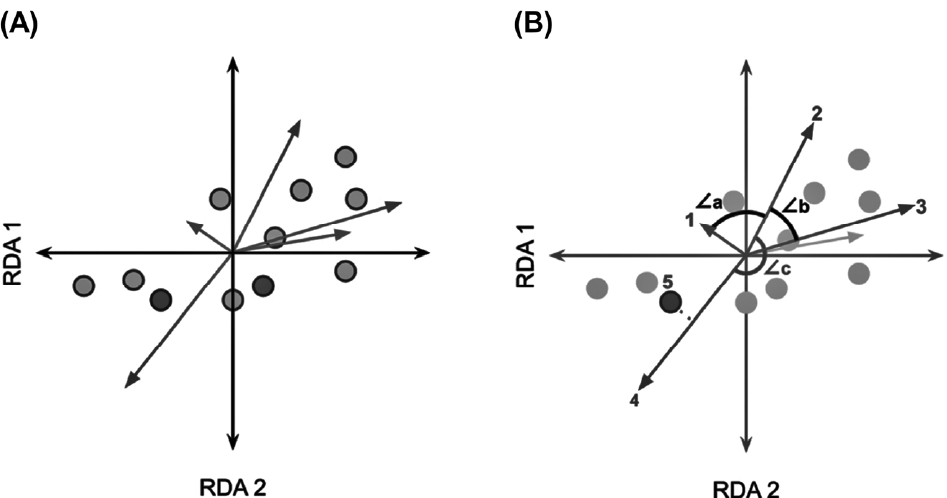
(Figure 8B). Projecting centroid points (dark grey points) representing species or rivers onto a vector (arrows) representing a geomorphic or community variable reflects the relationship between these variables.